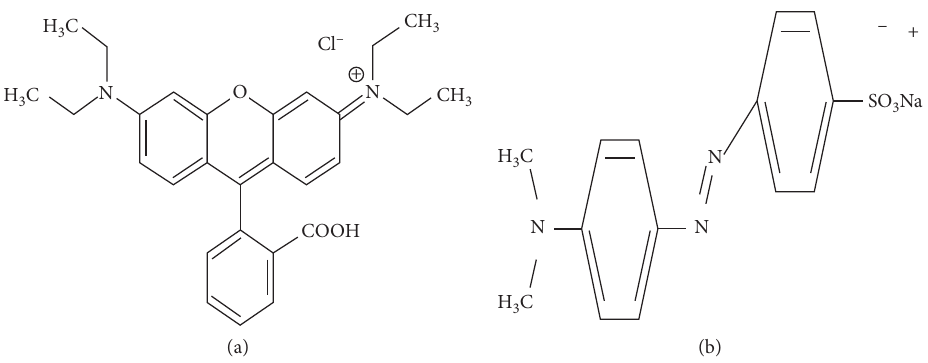
Figure 1: The chemical structures of rhodamine blue and methyl